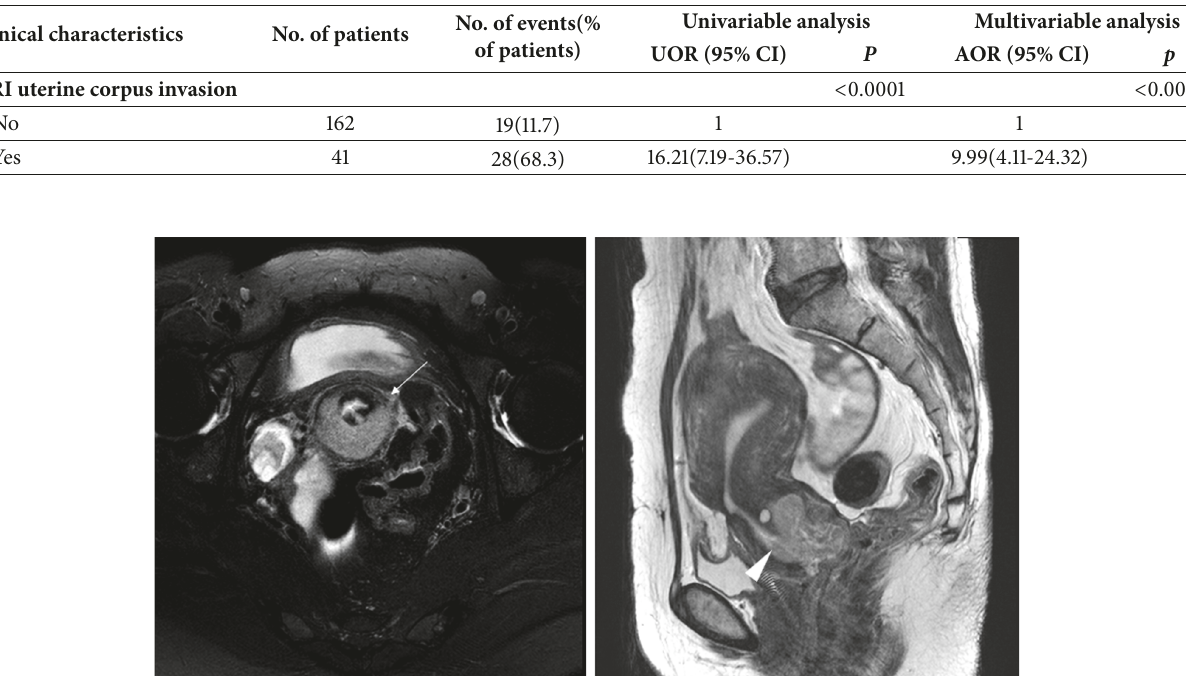
Figure 2: Stage IB1 cervical adenocarcinoma in a 42-year-old woman with radical hysterectomy (A) T2-weighted axial MR images show a moderated lobulated mass of uterine cervix with a focal disruption (arrow) of peripheral rim. The maximum diameter of the lesion is measured 3.6cm on the T2-weighted sagittal image. At histopathological finding, no parametrical lesion was found. MRI stage T2b ( ≤ 4 cm) was overdiagnosed as final pathologic stage T1b1.